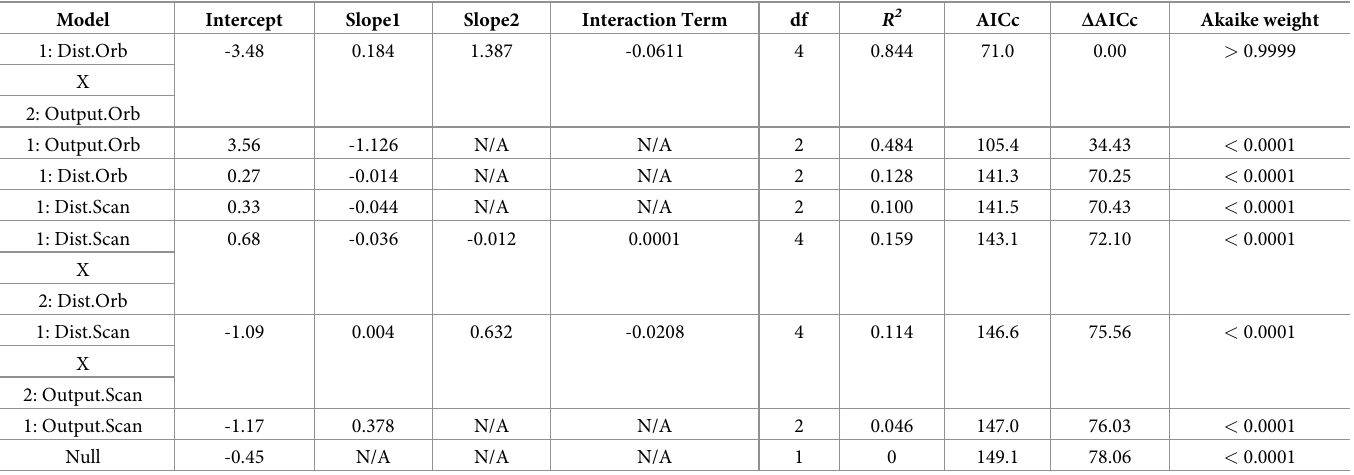
Table 7. Summary of model selection results for hybridization rate in C . scandens . Model